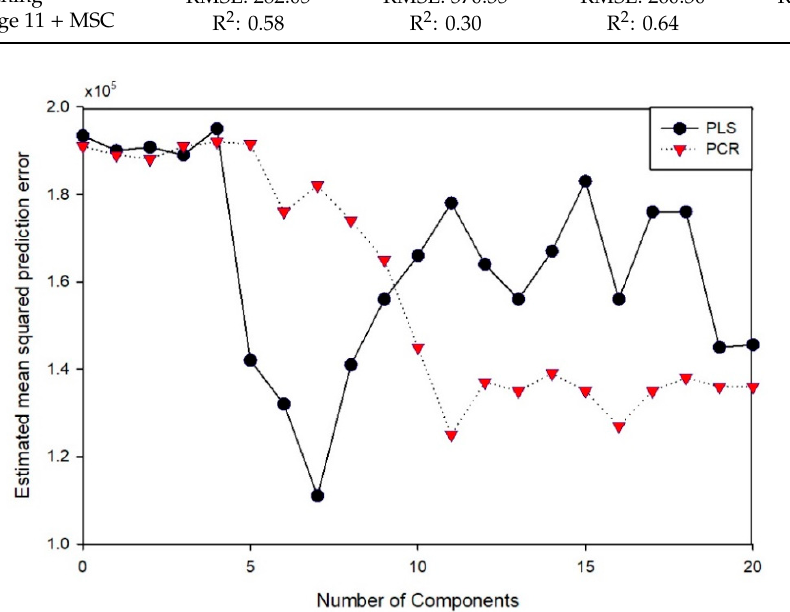
Figure 8. Intensity values of the NIR band for each PO 4- concentration. ( a ); PO 4 absorption wavelength